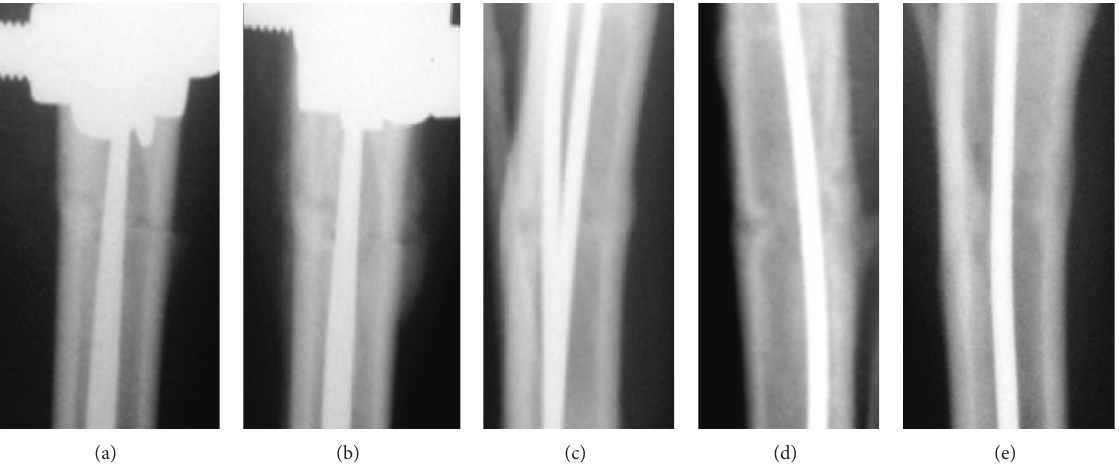
Figure 2: Group 2 radiographs: (a) day 7, (b) day 14, (c) day 30, (d) day 45, and (e) day